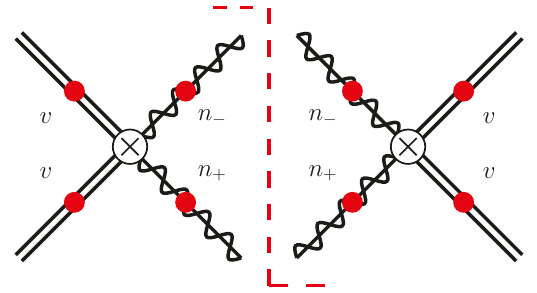
Figure 11 . Diagrammatic representation of the one-loop soft